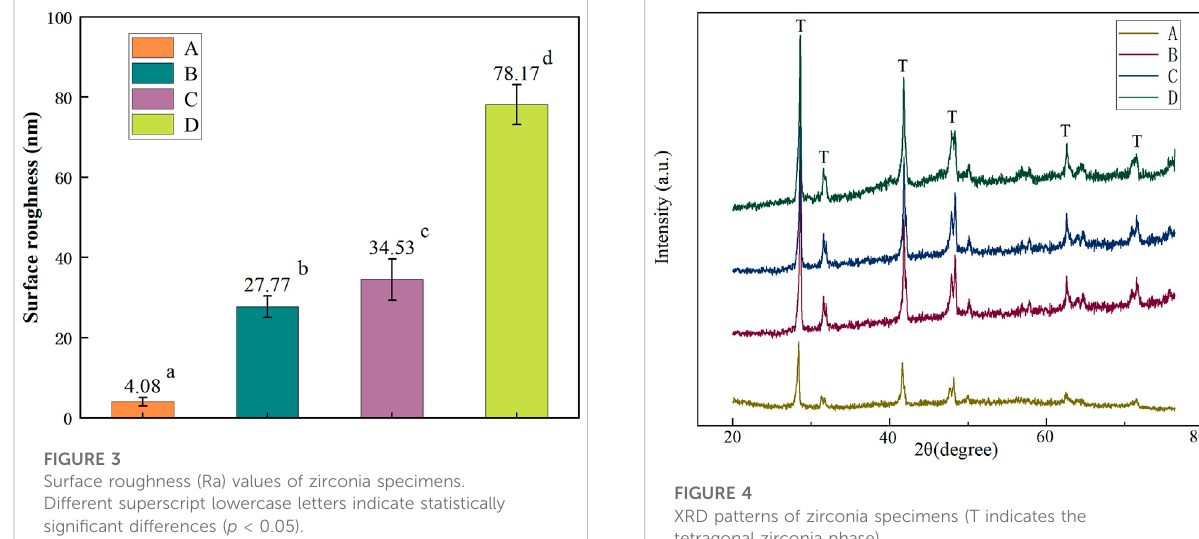
FIGURE 3 Surface roughness (Ra) values of zirconia specimens.